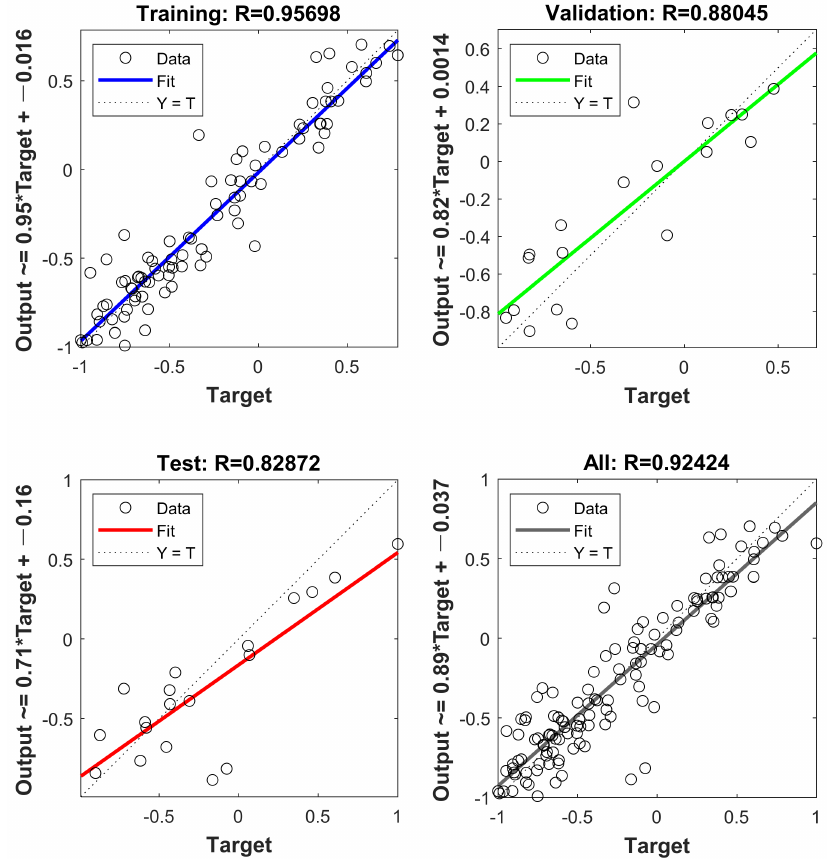
Figure 9. SCG-ANN model fitting.